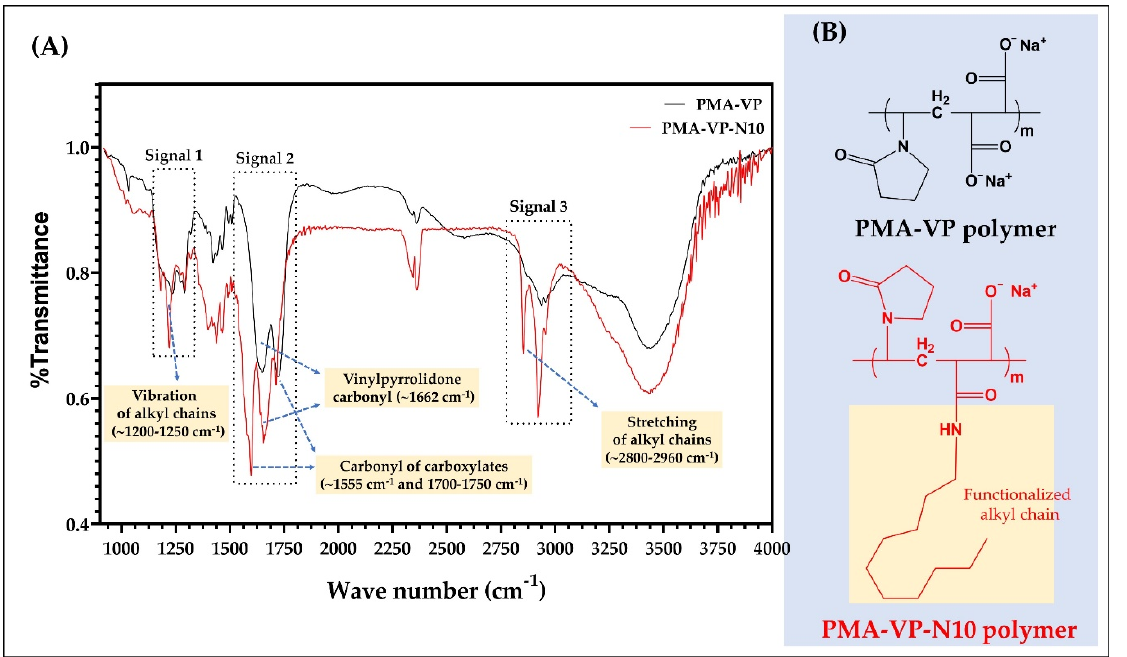
Figure 2. (A) FTIR spectra and (B) chemical structures of the comonomer units of PMA-VP and 179 Figure 2. ( A ) FTIR spectra and ( B ) chemical structures of the comonomer units of PMA-VP and PMA-VP-N10 polymers. PMA-VP-N10